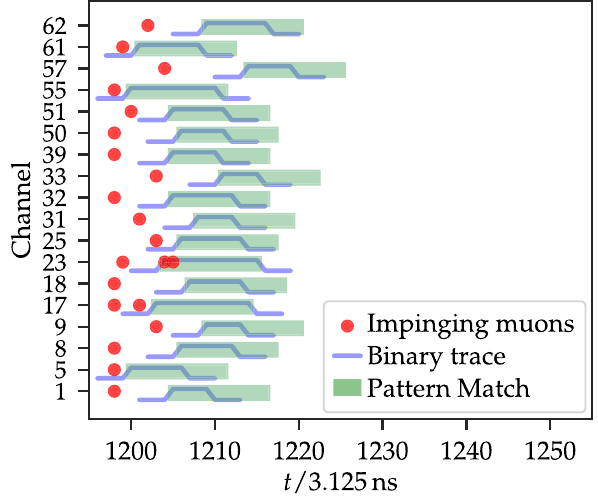
Fig. 3 Simulation of the signal generated by muons of an air-shower simulated event on a UMD module. The muons (circles) impinge at a certain time (x-axis) on the different segments of the detector, which are coupled to a channel (y-axis), generating a binary signal (lines), which are then matched to a single-muon pattern